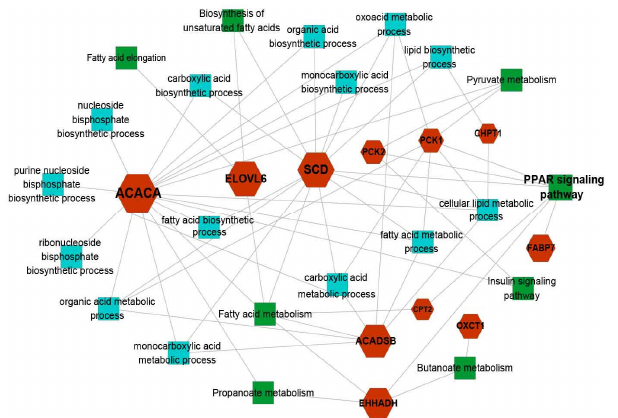
Figure 7. Eleven candidates involved in GO terms and KEGG pathways regarding fat deposition. The cyan and green squares, respectively, show GO terms and KEGG pathways. Genes marked in red represent candidate genes identified in this study.